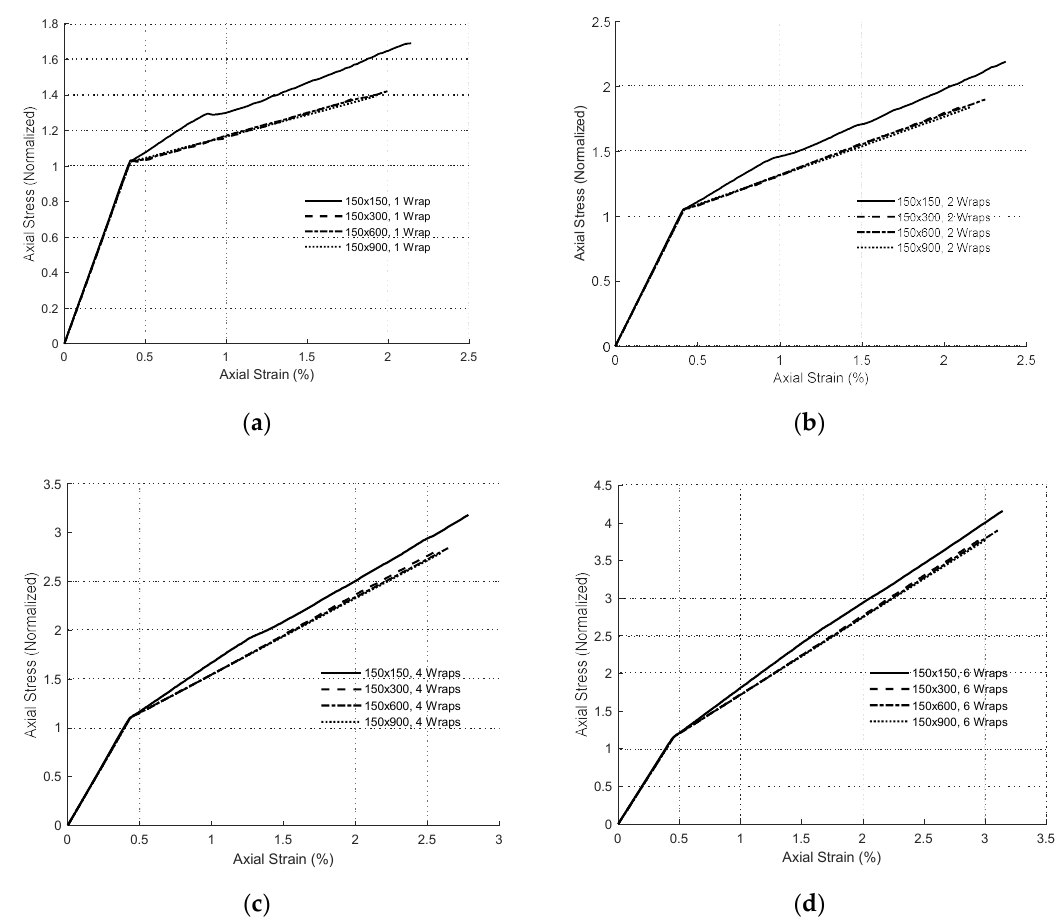
Figure 3. Effect of cylinder slenderness on the axial stress–axial strain response of concrete cylinders: ( a ) one FRP wrap, ( b ) two FRP wraps, ( c ) four FRP wraps, and ( d ) six FRP wraps.